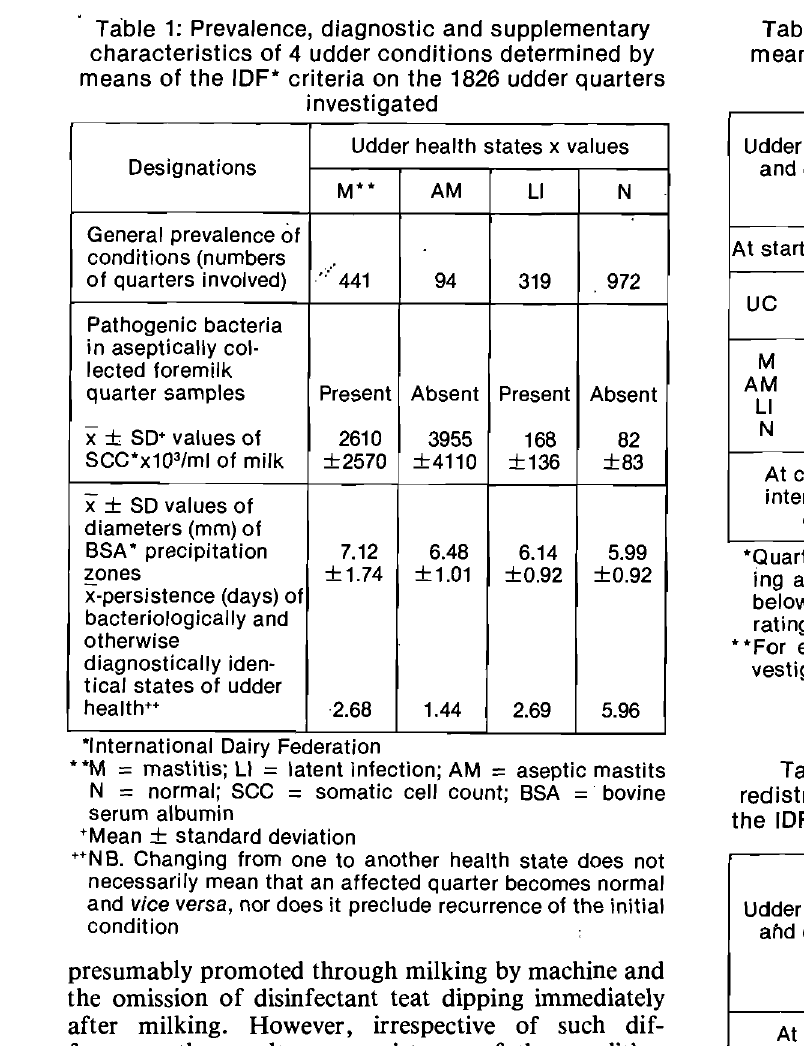
Table 3: Initial distribution and